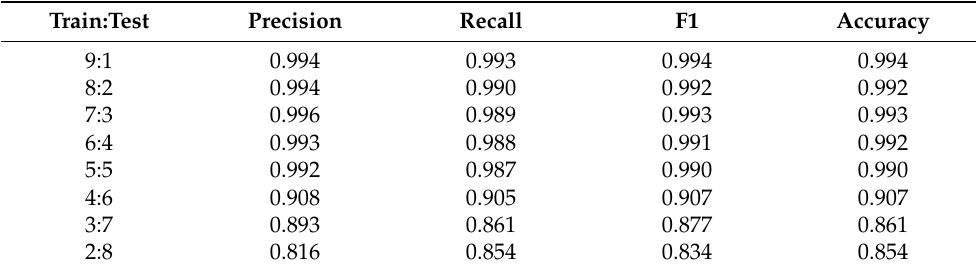
Table 2. Experimental results under different training and test set